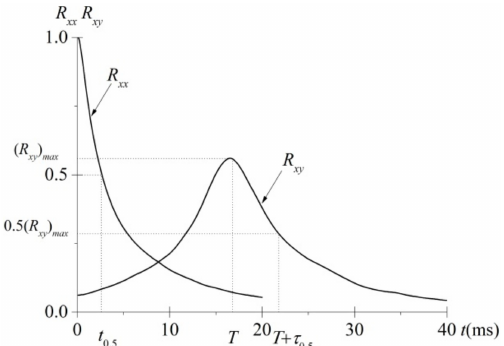
Figure 3. Auto-correlation and cross-correlation functions (T1–8: q w = 2.29 m 2 /s; V = 7.51 m/s;